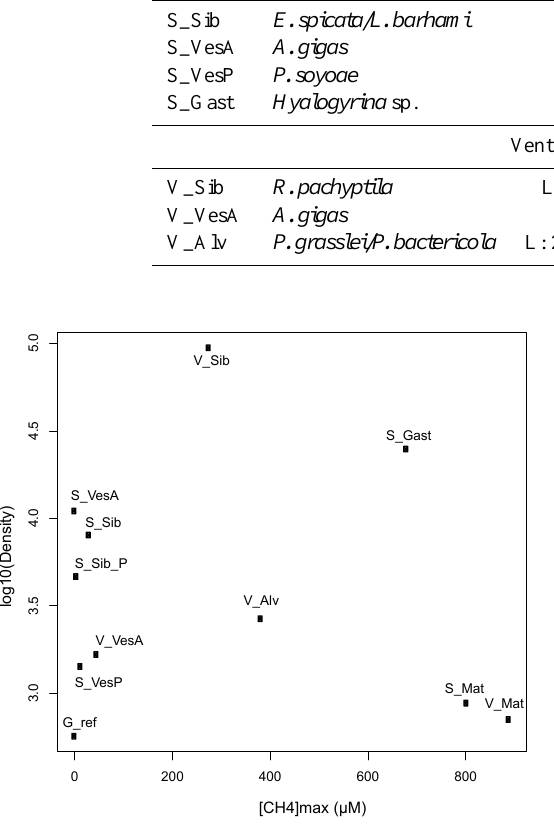
Figure 4. Log-transformed macrofaunal densities according to maximum methane concentrations in